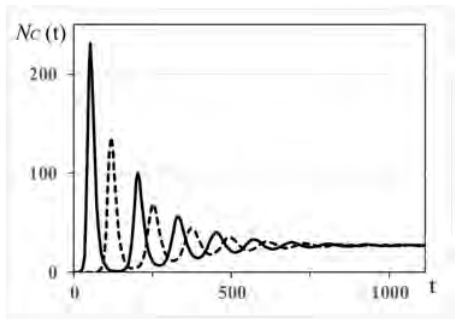
Fig. 16. of N C ( t ) for oscillating dynamics for 2 different initial values ϕ ( a ) .